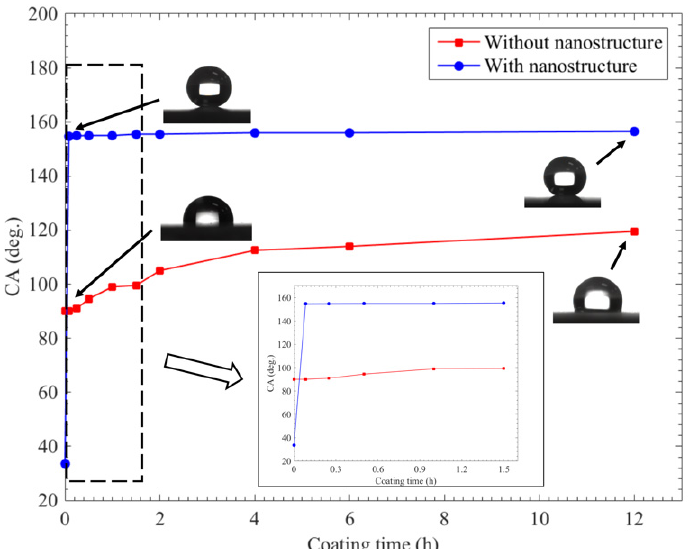
Figure 10. Static contact angles at different modification times (inset shows the contact angles for the coating time between 0 and 1.5 h).